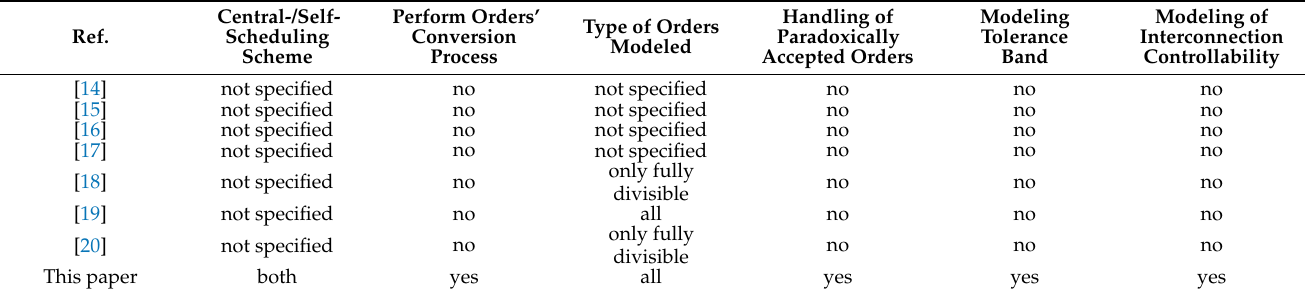
Table 1. Main features of the research works presented in the literature.